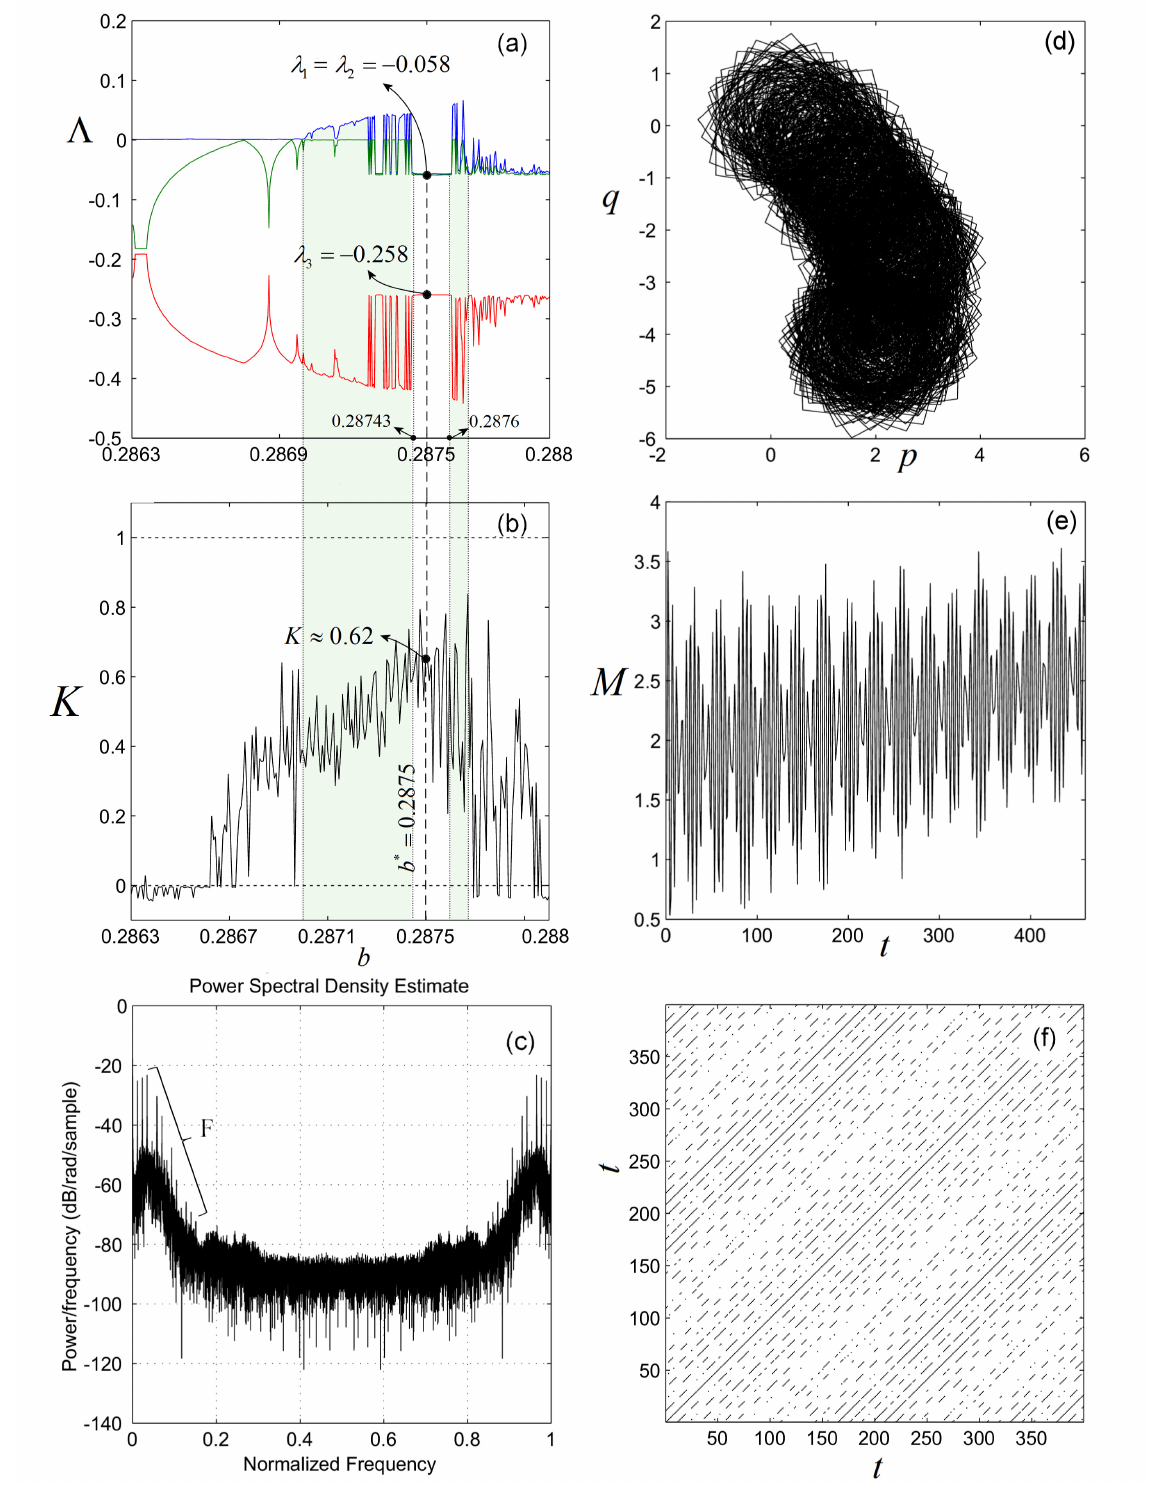
Figure 6. The HSNA H for b = 0.2875. ( a ) The variation in the Lyapunov spectrum; ( b ) the variation in the median K ; ( c ) power spectral density; ( d ) the graph of p and q ; ( e ) the graph of the mean-square displacement M ; ( f ) the recurrence